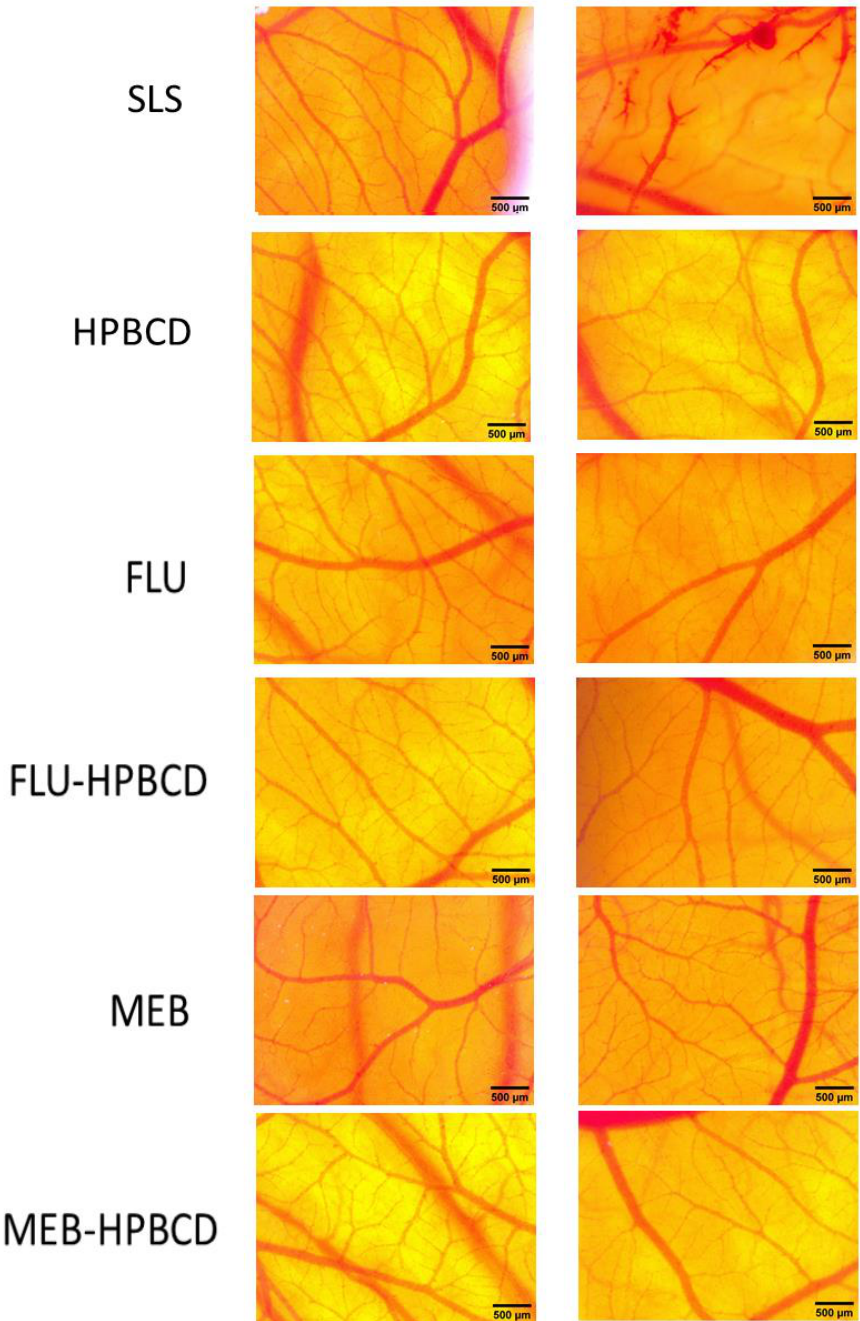
Figure 12. Stereomicroscopic images of CAM after irritation with SDS and treatment with MEB, FLU, and their HPBCD